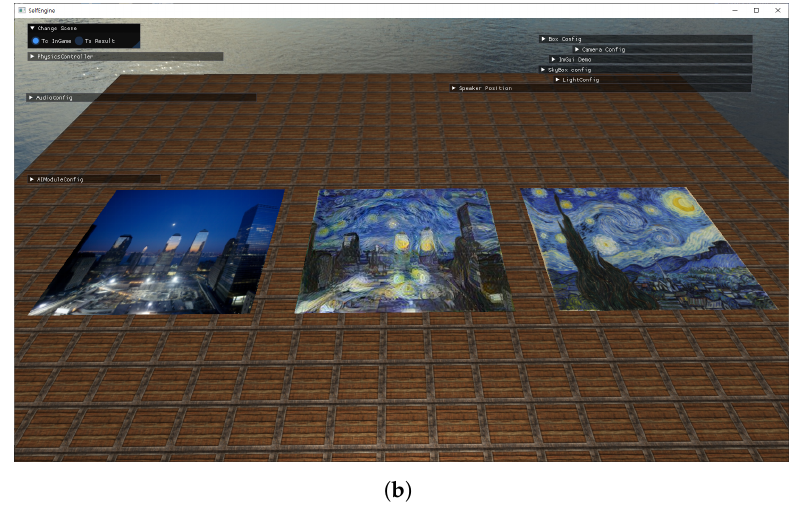
Figure 7. Screenshots from a neural style transfer. ( a ) Before the style transfer, ( b ) after the transfer completed.